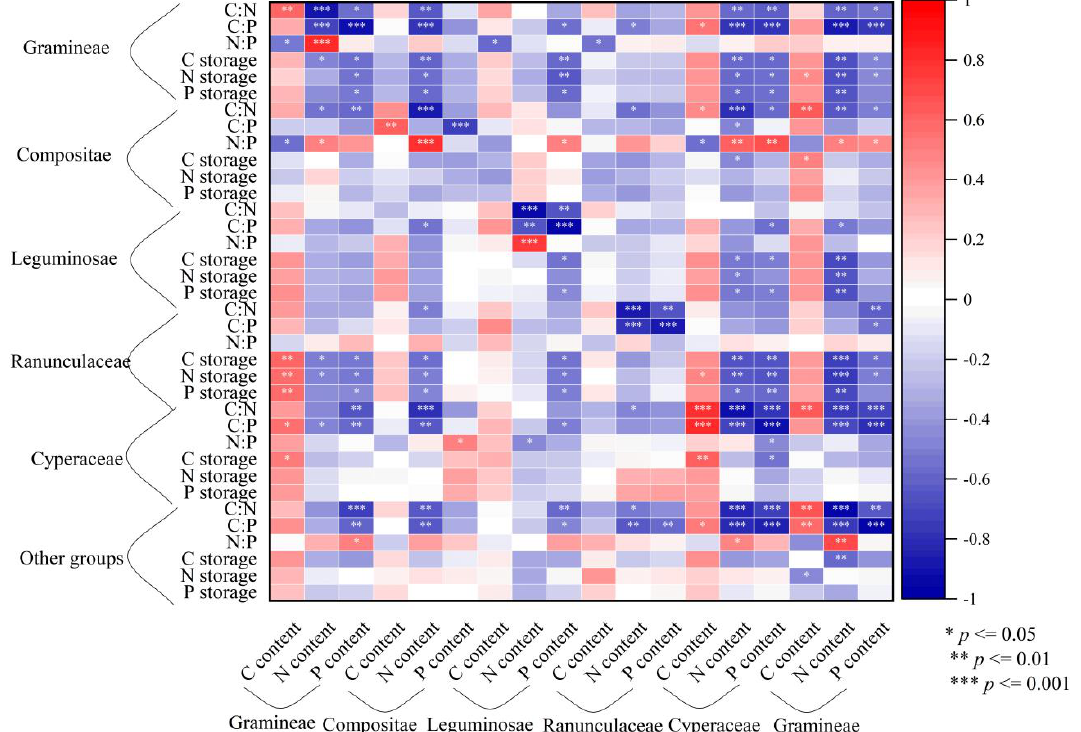
Figure 5. Correlation between nutrient content, stoichiometry and storage in plant functional groups. * 0.01 < p ≤ 0.05, ** 0.001 < p ≤ 0.01, *** p ≤ 0.001.